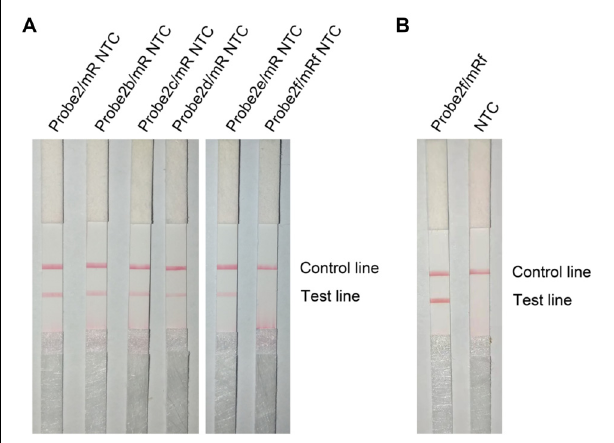
FIGURE 8 | Test of the base-substituted primer–probe sets on RPA–LFS. (A) These base-substituted probes and primers were tested for false-positive signals in RPA reaction and LFS detection with no DNA template. (B) The optimized primer–probe set Probe2f/mRf was tested for amplification performance in RPA-LFS. The NTC lanes are the no-template controls of the reactions. The name of each primer–probe set is indicated on top of the corresponding strip. The positions of test and control lines are marked on the right of the strip image. The reactions were performed at 40 ◦ C for 30